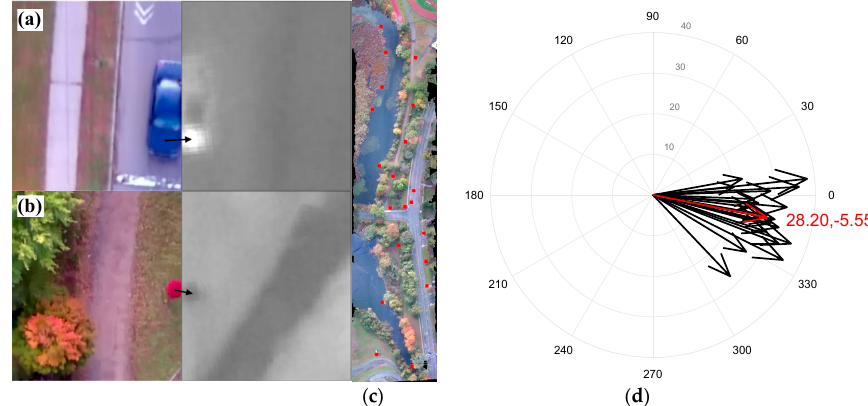
Figure 6. Removal of misalignment between the RGB and the thermal orthomosaics. ( a,b ): two typical views clipped from the orthomosaics, with two recognizable objects [a hot car engine in (a) and a cold red tree in (b)]. The left panel shows the RGB view and the right panel shows the thermal view. The black arrow is the vector of misalignment. ( d ): 20 misalignment vectors (black arrows) sampled from ( c ) and the mean misalignment vector (red arrow). The two red numbers are components of the mean vector.